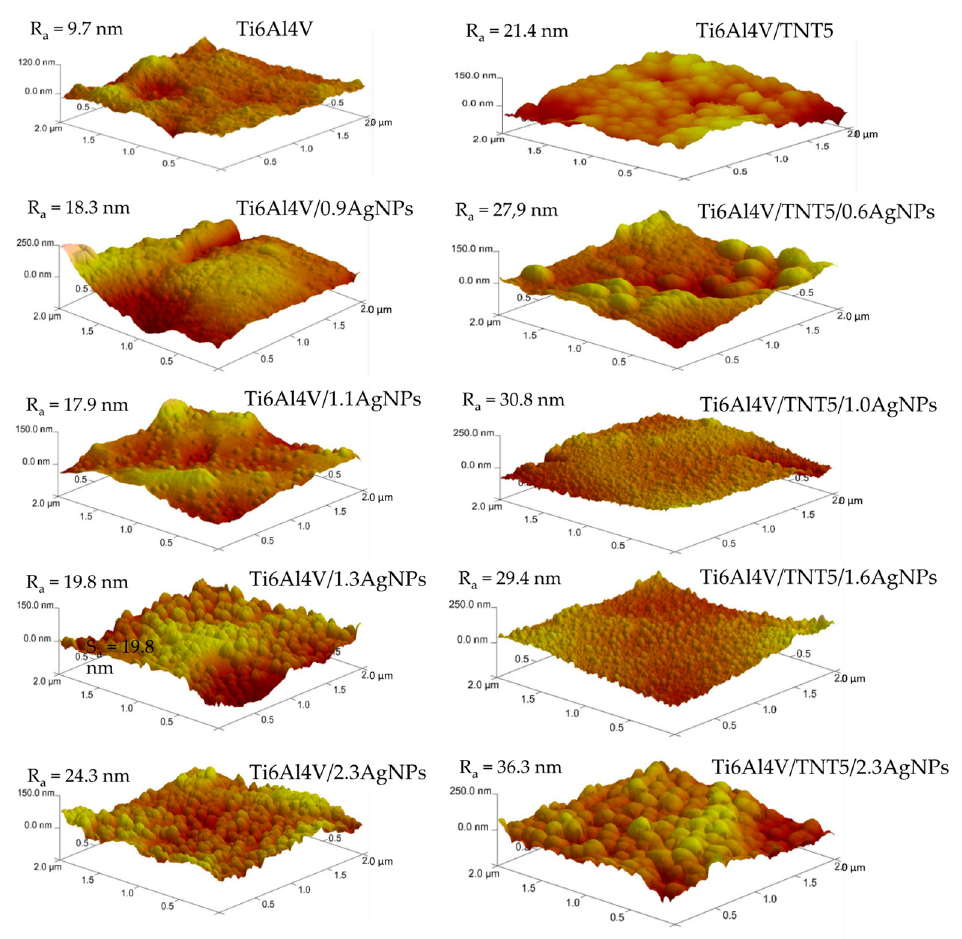
Figure 3. Atomic forces microscopy (AFM) images and R a parameters determined for the Ti6Al4V, Ti6Al4V/AgNPs, Ti6Al4V/TNT5, and Ti6Al4V/TNT5/AgNPs samples. J. Clin. Med. 2019 , 8 , x FOR PEER REVIEW